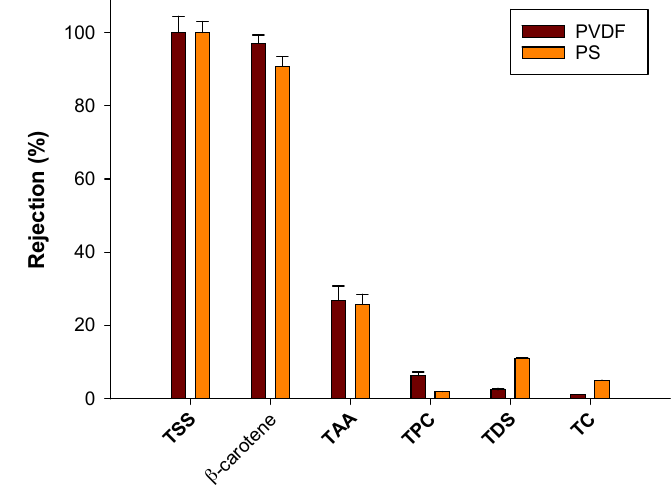
Figure 2. Rejection of hollow fiber UF membranes towards analyzed compounds (PS, polysulphone; PVDF, polyvinylidene fluoride; TSS, total suspended solids; TDS, total dissolved solids; TPC, total phenolic content; TAA, total antioxidant activity; TC, total carbohydrates).